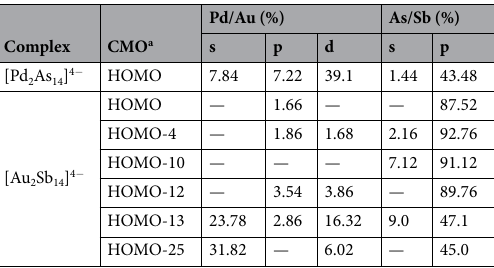
Table 2. Composition analysis for selected canonical molecular orbitals (CMOs) in D 2 h [Pd 2 As 14 ] 4 − ( 1 ) and